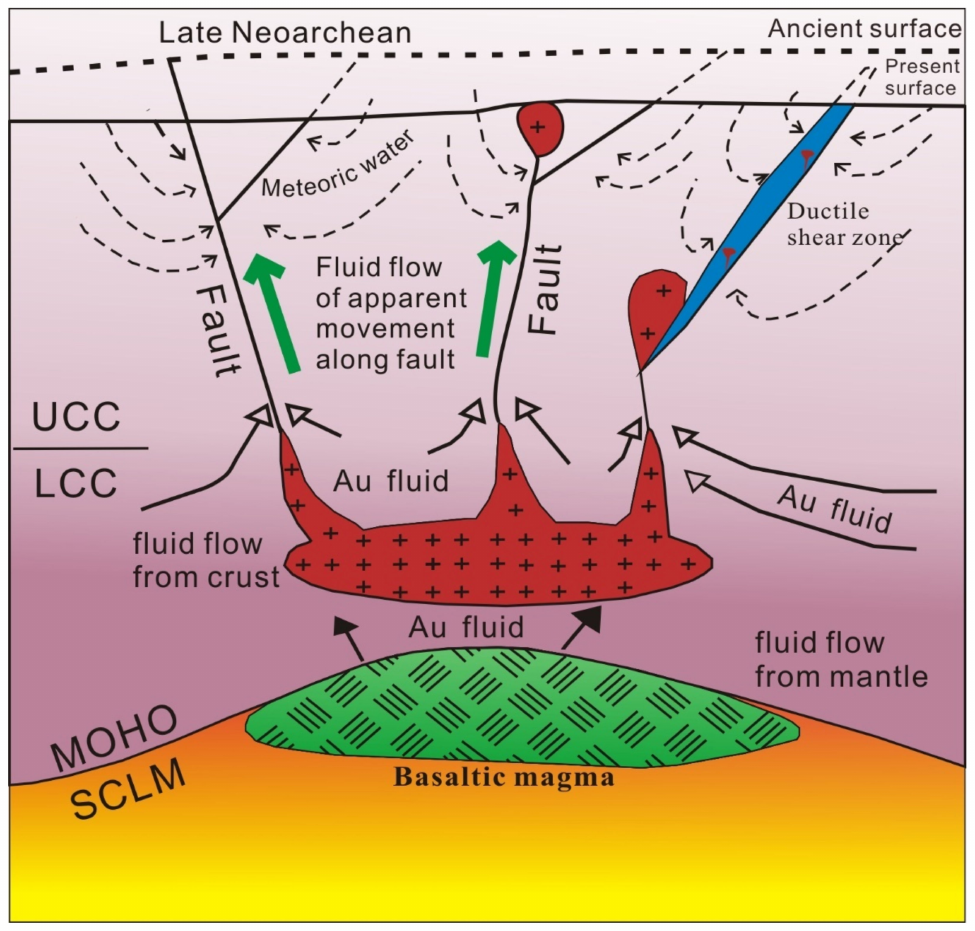
Figure 10. Gold mineral transport model within Neoarchean TTG in the Liuhe orefield (after [95]). UCC-upper continental crust; LCC-lower continental crust; SCLM-subcontinental lithospheric